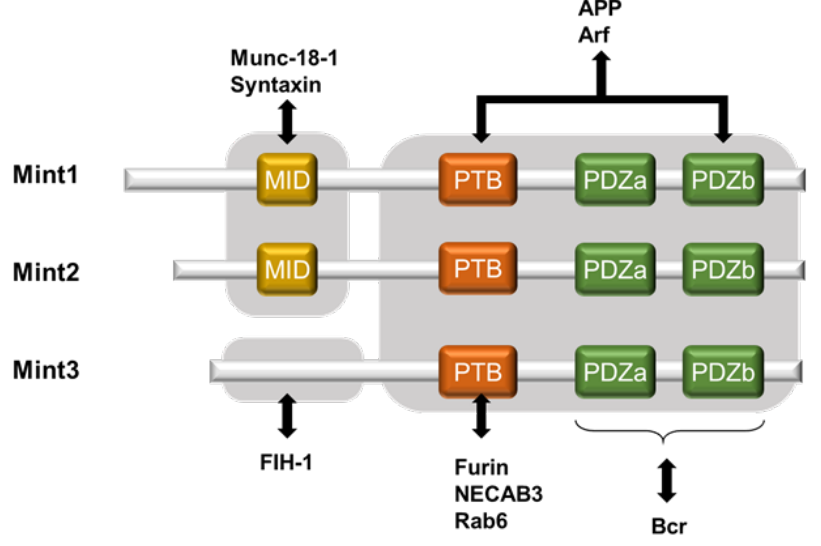
Figure 1. The schematic structures of Mint proteins with their binding partners. Mint family comprises well-conserved C-terminal region with one phosphotyrosine-binding domain (PTB) and tandem PDZ domains (PDZa and PDZ b); differential N-terminal region with Munc-18-1 interacting site (MID) only for Mint 1 and 2; FIH-1 binding site for Mint3. FIH-1—Factor inhibiting HIF-1, NECAB3—N-terminal EF-hand calcium binding protein 3, APP—amyloid precursor protein, and Arf—ADP-ribosylation factor